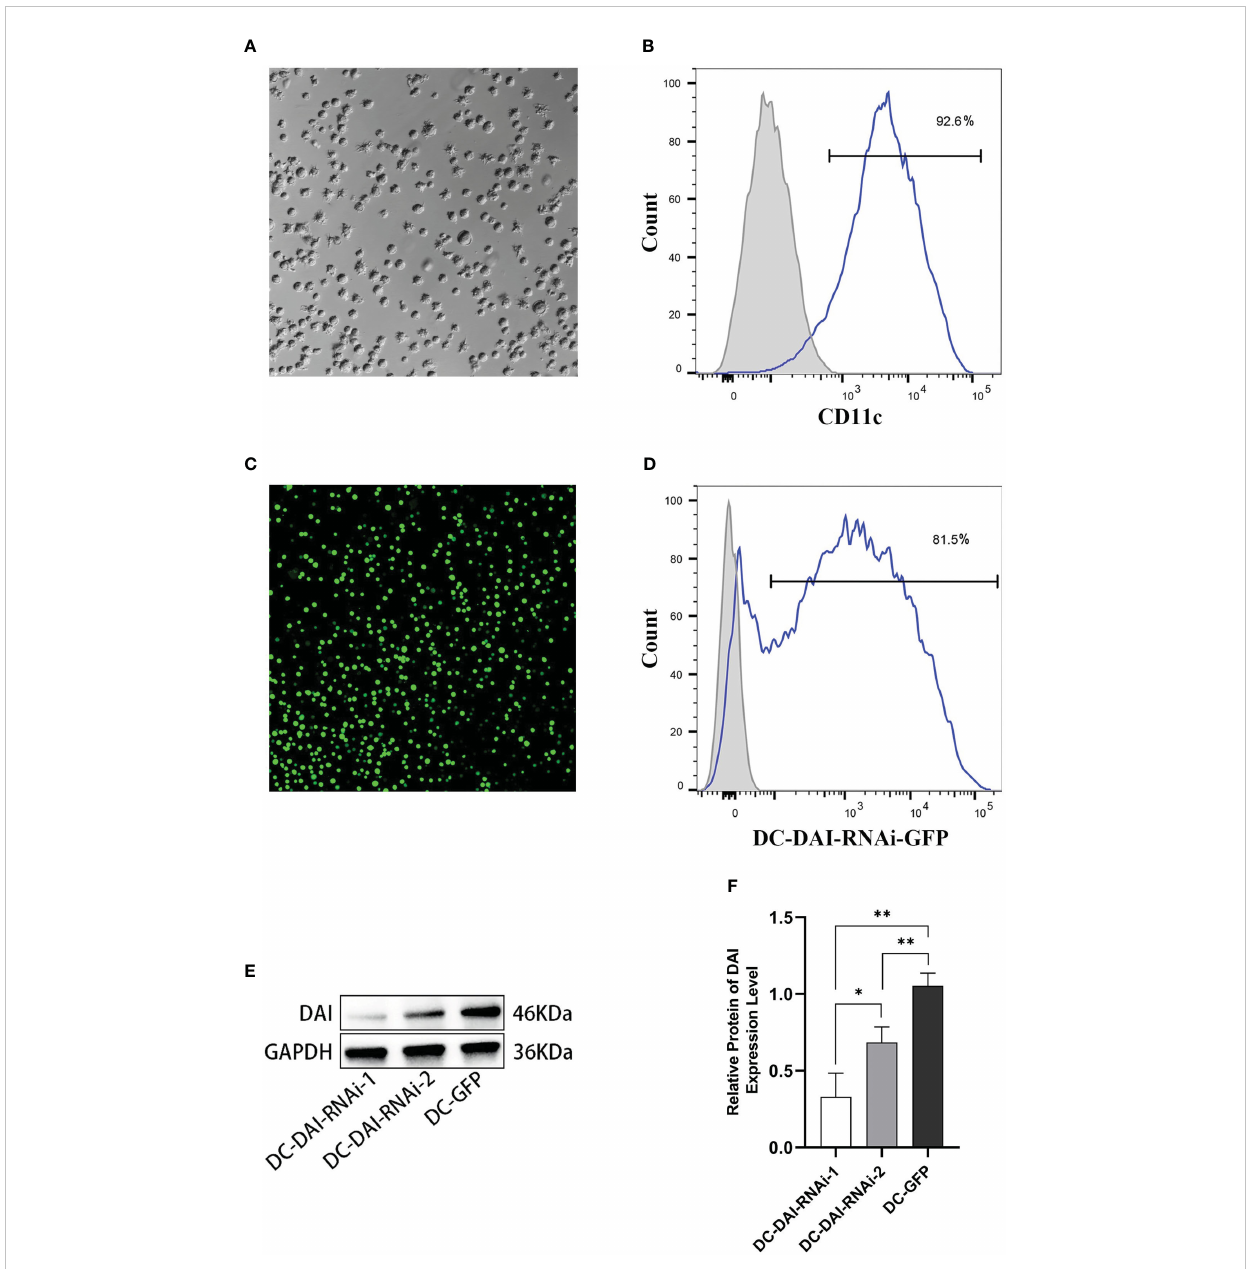
FIGURE 1 Generation of mouse bone marrow-derived dendritic cells (BMDCs) and transduction of the adenovirus vector. (A) Mature DCs (×200). (B) Purity of BMDCs (n=3). (C) The expression of green fl uorescent protein (GFP) in DCs 48 h after AdV-DAI-RNAi-GFP transduction observed in fl uorescence microscopy (×200). (D) Transduction ef fi ciency of AdV-DAI-RNAi-GFP (n=3). (E, F) Western blot analysis of DAI protein expression levels in DCs transduced with AdV-DAI-RNAi-1 and AdV-DAI-RNAi-2 (*P < 0.05, **P < 0.01,